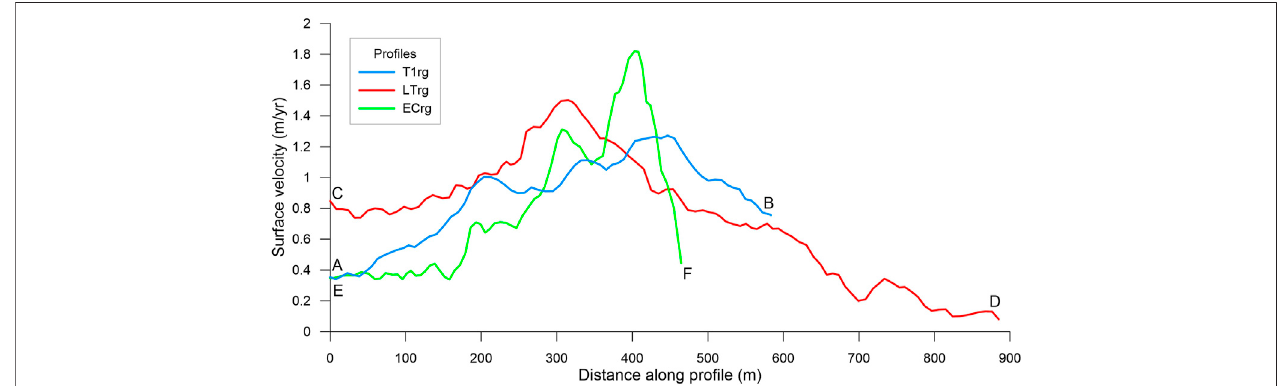
FIGURE 6 | Longitudinal surface velocity pro fi les (2014 – 2019) for the Tapado 1 (T1rg), Las Tolas (LTrg) and El Cachito (ECrg) rock glaciers.